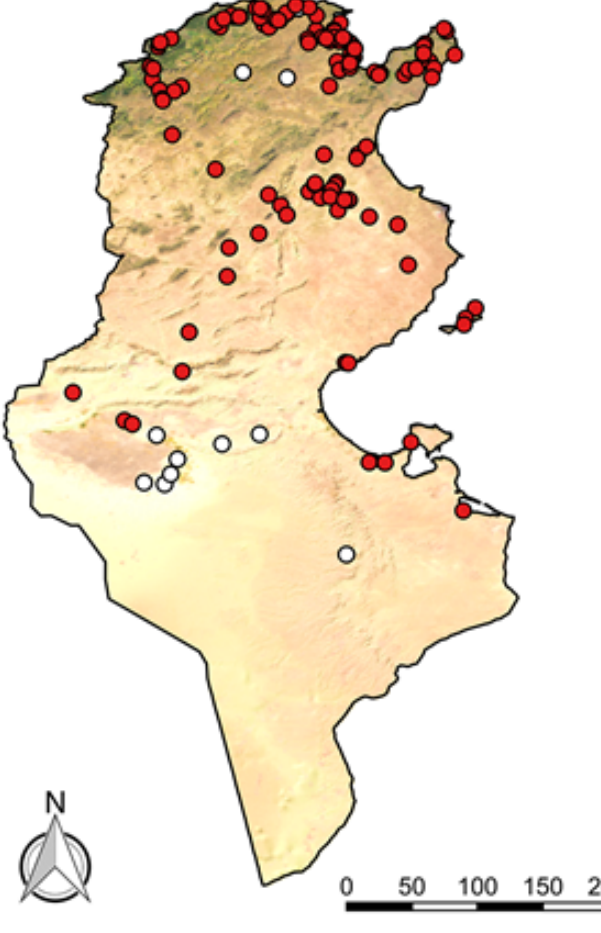
FIGURE 1. Location of the sampled sites. Red dots: sites where at least one large branchiopod species was collected; white dots: sites where no large branchiopods were